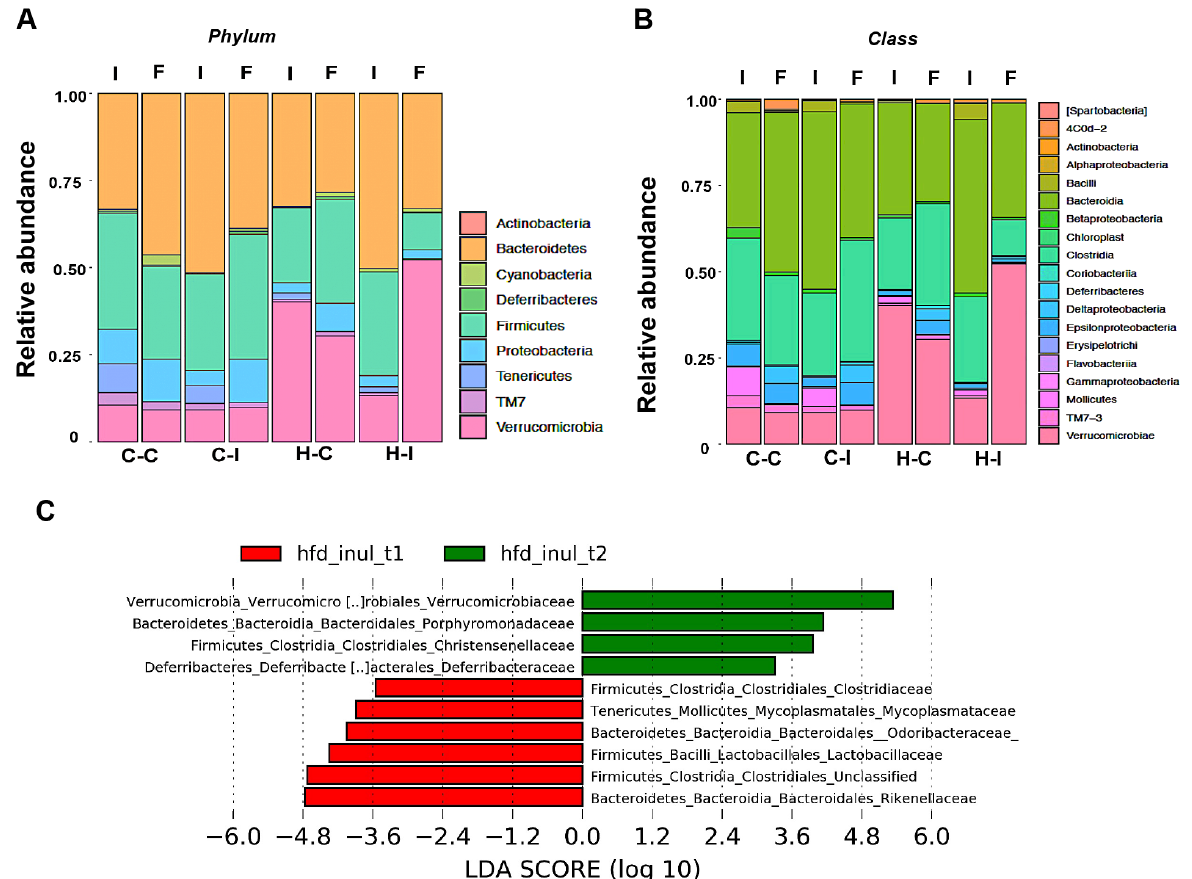
Figure 4. Akkermansia significantly increases in the gut microbiota after inulin supplementation. The corresponding relative abundance at the phylum ( A ) or class ( B ) level is presented for each group at the beginning (I) or at the end of eight weeks (F) of inulin supplementation ( C ) Linear discriminant analysis effect size is presented for the H-I group indicating the enterotype for this group before (red bars) or after (green bars) the eight weeks of treatment. Numbers indicate the correspondence fold change in log 10 scale.